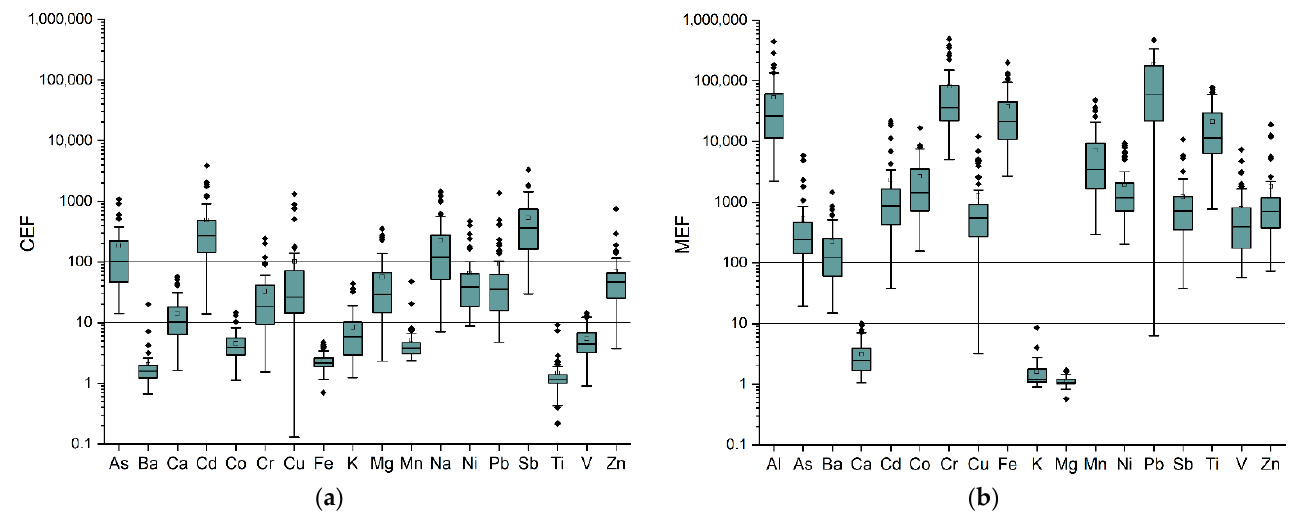
Atmosphere 2021 , 12 , x FOR PEER REVIEW Figure 1. Box plots showing ( a ) crustal and ( b ) marine enrichment factors calculated for all PM 10 samples collected in 2015.